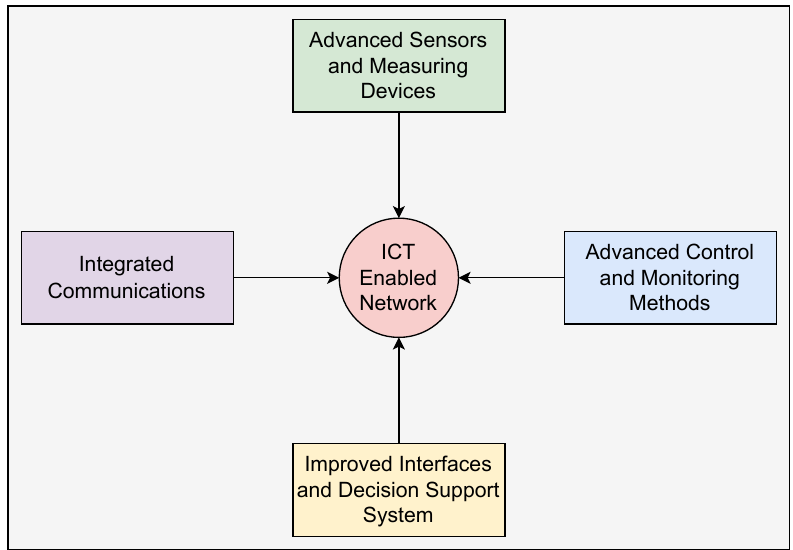
Figure 3. Merits of ICT-enabled